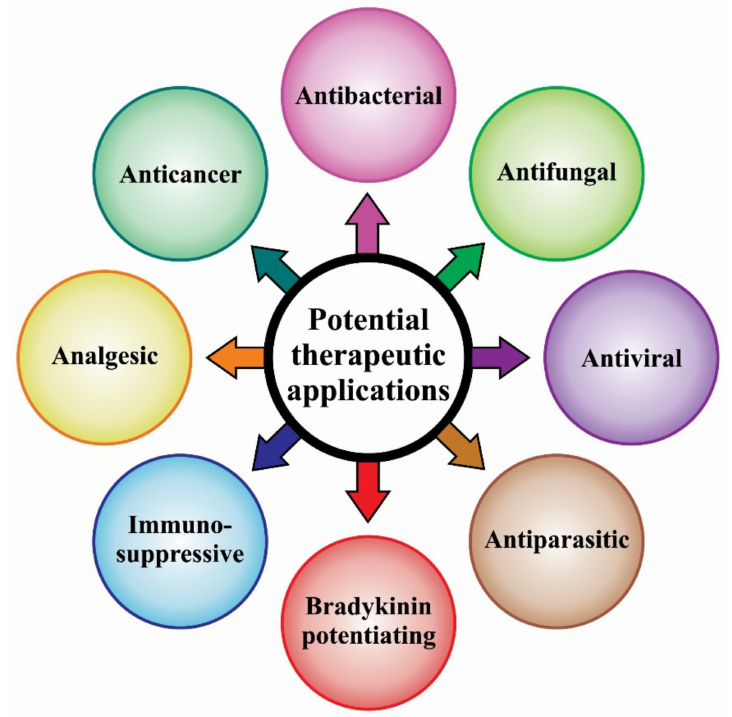
Figure 4. The potential therapeutic applications of scorpion venom compounds discussed in this article. Table 1. Scorpion-derived compounds with antibacterial activities. MDR: multidrug